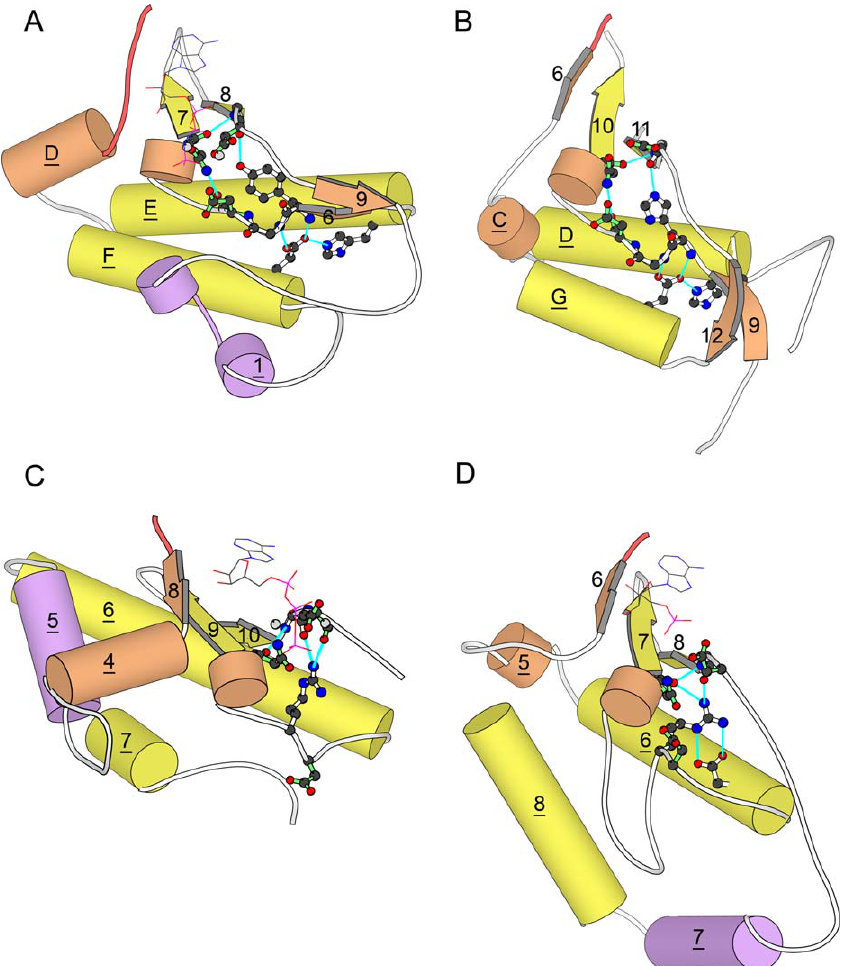
Figure 5. Shared Hydrogen-Bonding Networks between Distantly Related Structures in the Kinase-Like Superfamily Colors and nomenclature for secondary structural elements are identical to those provided in Figure 2. Structures shown are the C-terminal subdomains of four structures: (A) PKA [70]; (B) CKA-2 [23]; (C) PI3K [21]; and (D) AFK [22]. For clarity, some portions of structures are omitted. Residues involved in the shared hydrogen-bond networks are shown in a ball-and-stick rendering. For clarity, side-chains are omitted for residues that only participate in the network via backbone interactions. Residues involved directly in catalysis or metal binding are shown with light-green stick regions in the ball-and-stick rendering. Metal atoms, when present, are shown as gray spheres. ATP (or ATP analog), when present, is shown in a line rendering. Hydrogen bonds are shown in cyan. The orientation of the structures is similar but not identical (structures were rotated somewhat to make H-bond contacts more visible). Molecular renderings in this figure were created with MOLSCRIPT [90]. DOI: